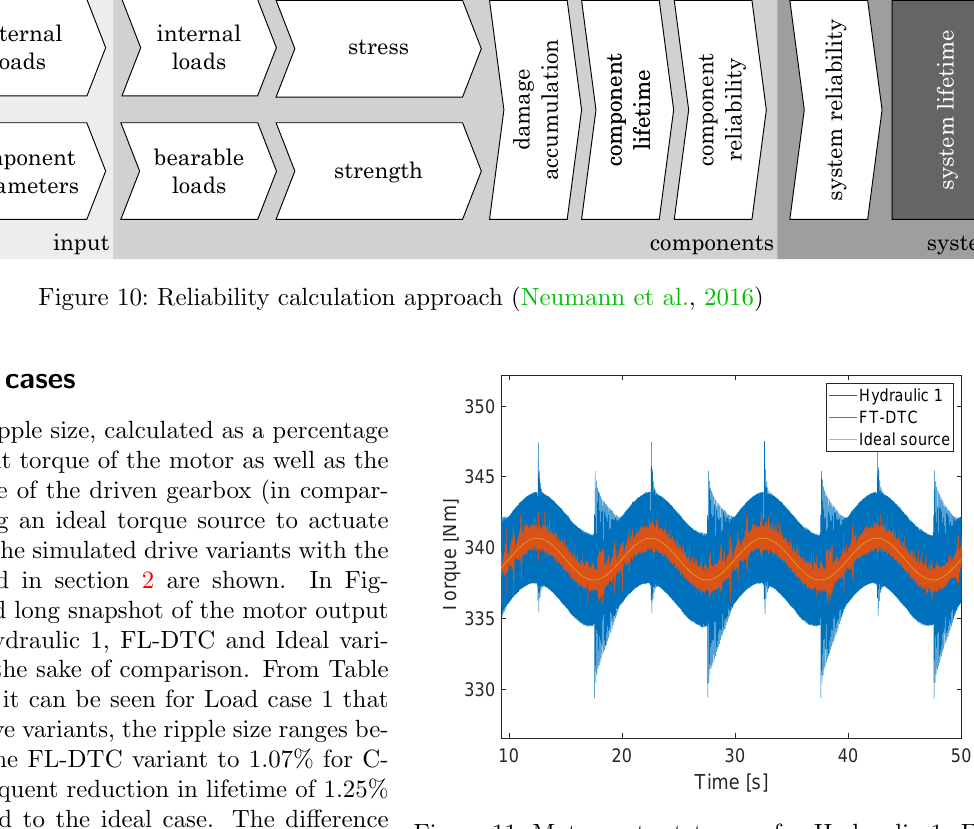
Figure 11: Motor output torque for Hydraulic 1, FT- DTC and Ideal variants (Load case